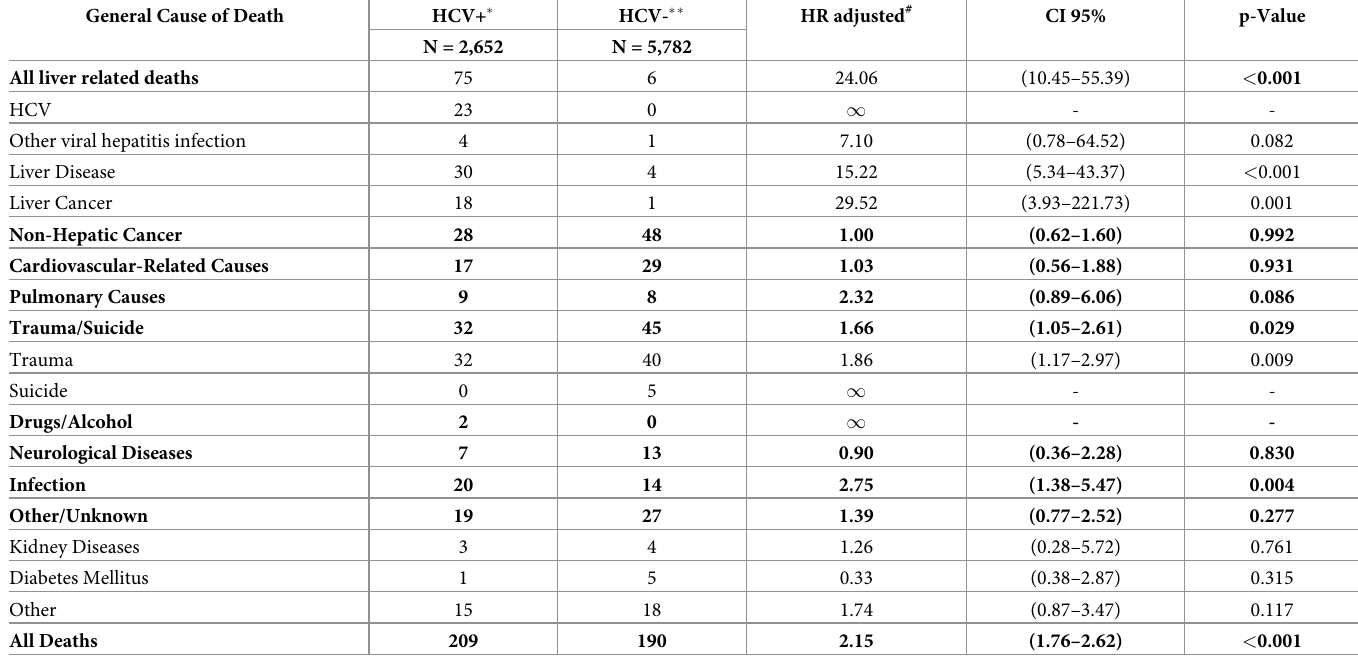
Table 3. Deaths organized by underlying cause of death and by HCV serological